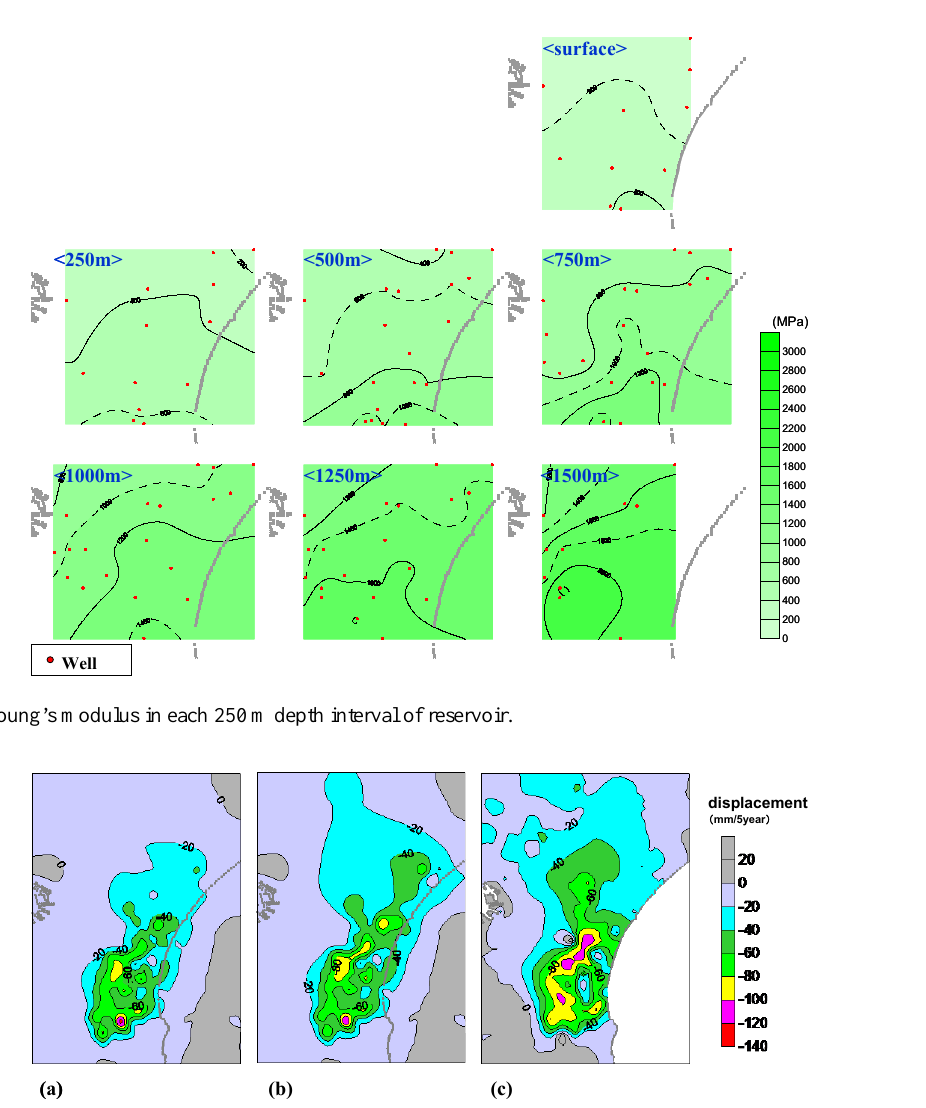
Figure 5. Comparison simulated and measured land subsidence from 1990 to 1994, (a) simulated result without modified Young’s modulus distribution, (b) simulated result with modified Young’s modulus distribution and (c) Leveling